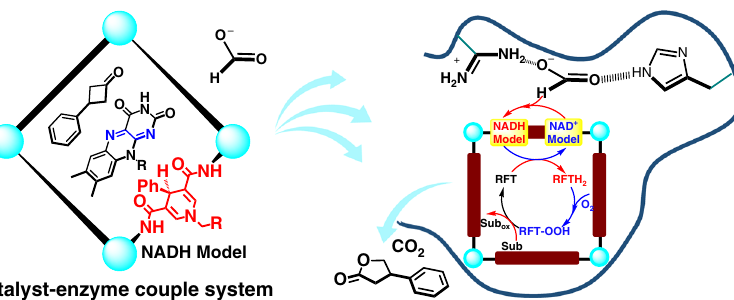
Fig. 1 Schematic of natural enzymatic system and catalyst – enzyme couple catalytic system. a Multienzyme cascade comprising fl avin-dependent monooxygenase and formate dehydrogenase connected by diffusion of the nicotinamide cofactor (NADH/NAD + ). b Superstructures comprising NADH- modi fi ed metal-organic capsule and enzyme achieve the coupling of arti fi cial and enzymatic catalysis in situ without diffusion.